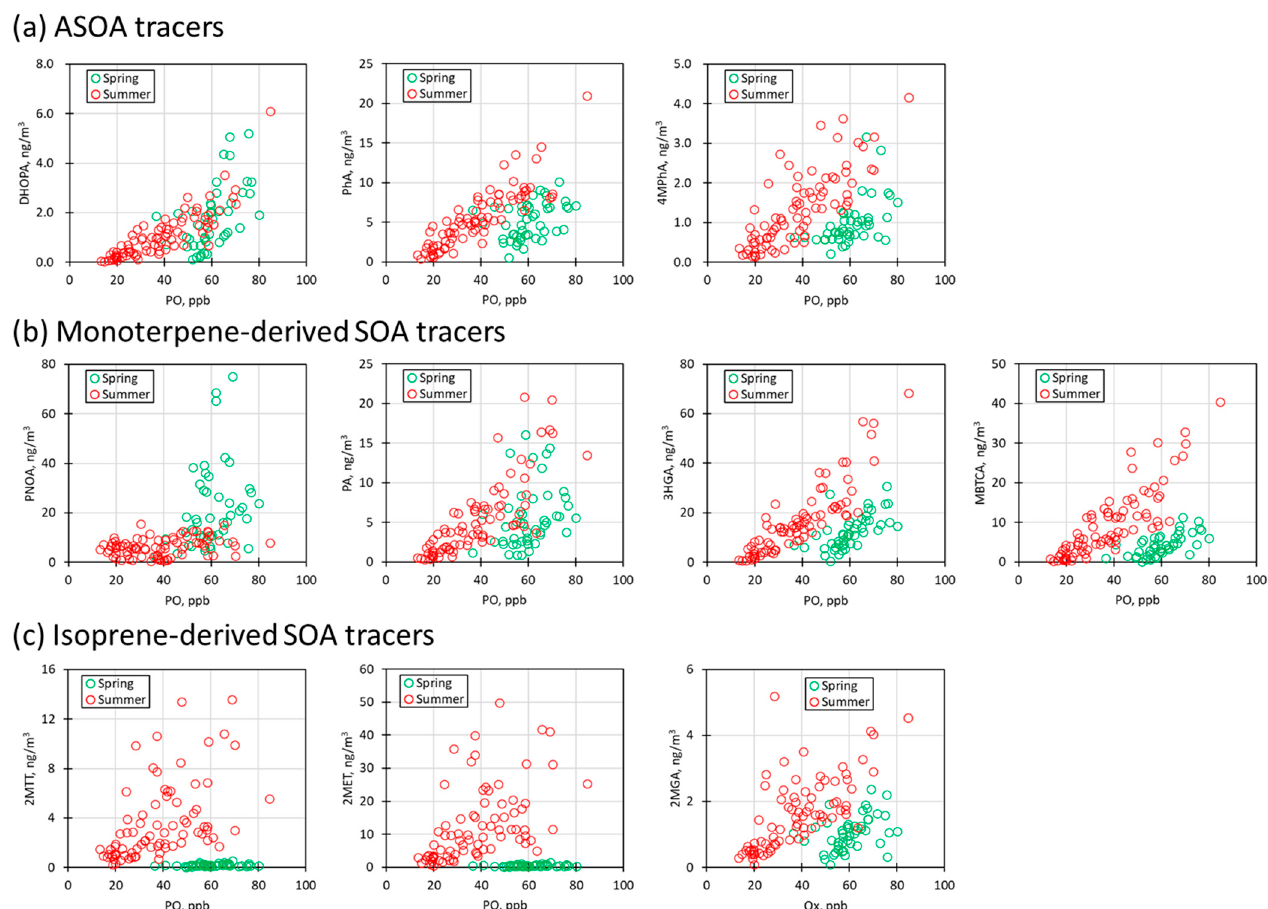
Figure 3. Scatter plots between potential ozone (PO) and SOA tracers with data from all sampling sites during spring (green) and summer (red): ( a ) ASOA tracers (DHOPA, phthalic acid (PhA), and 4-methylphthalic acid (4MPhA)) ( b ) monoterpene- derived SOA tracers (pinonic acid (PNOA), pinic acid (PA), 3-hydroxyglutaric acid (3HGA), and MBTCA), ( c ) isoprene- derived SOA tracers (2-methylthreitol (2MTT), 2-methylerythritol (2MET), and 2-methylglyceric acid